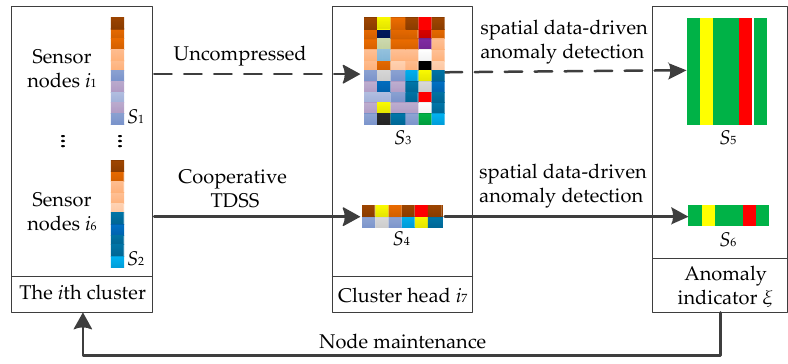
Figure 4. The data flow diagram of the i th cluster.